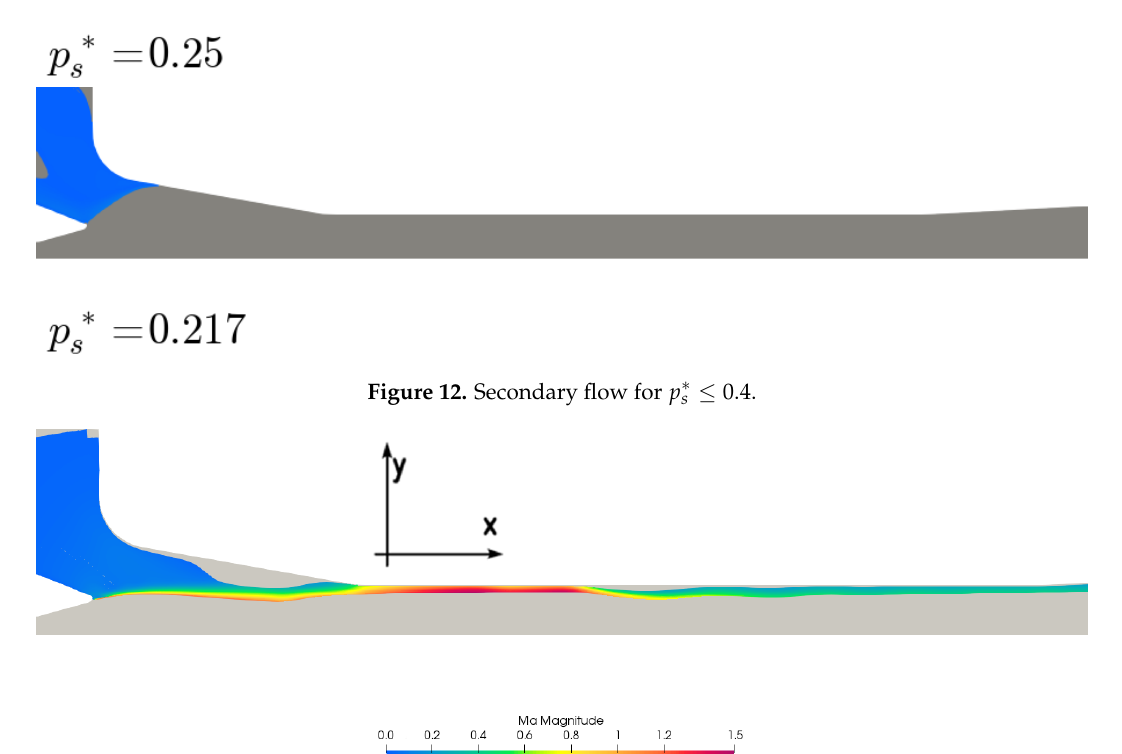
Figure 13. Secondary flow with explicit solver rhoCentralFoam for p ∗ s =